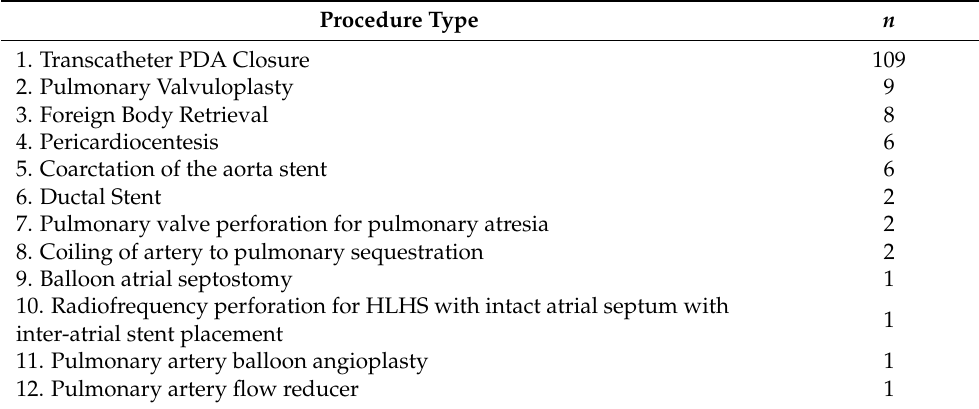
Table 1. Type and Number of